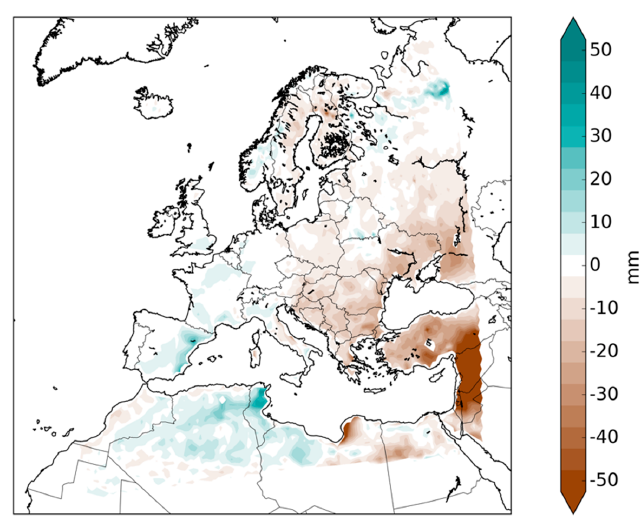
Figure 5. The di ff erence of mean soil moisture content during winter between the coupled and the Figure 5. The difference of mean soil moisture content during winter between the coupled and the uncoupled simulation. uncoupled simulation.